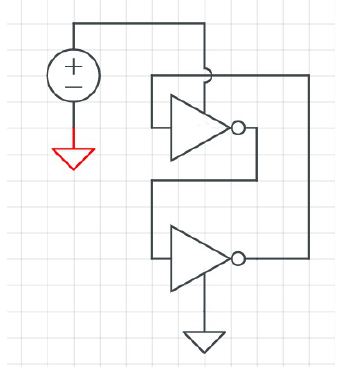
Figure 7. SRAM PUF